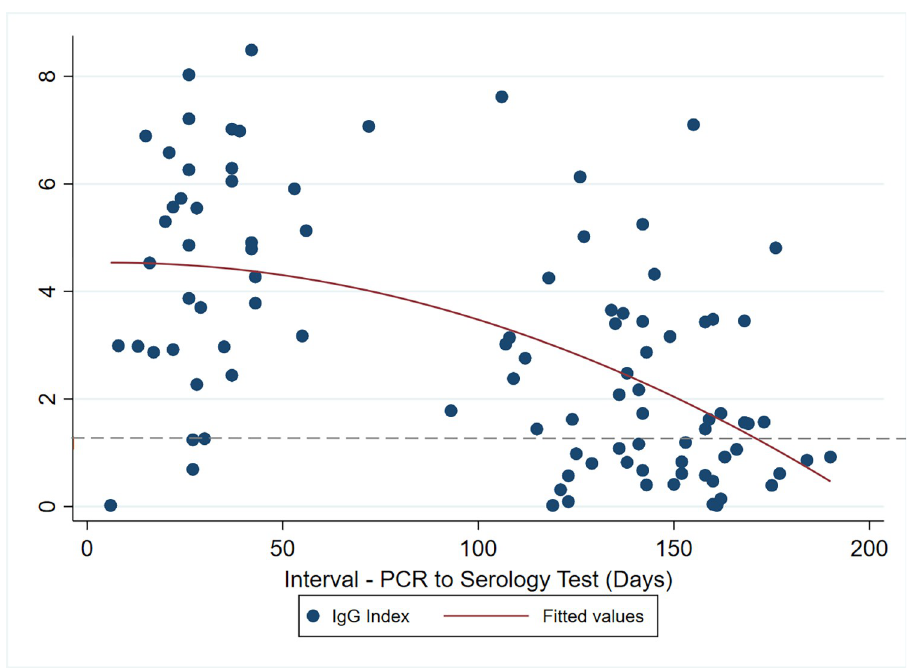
Fig 2. Antibody index at various time points post-SARS-CoV-2-19 PCR+ test.